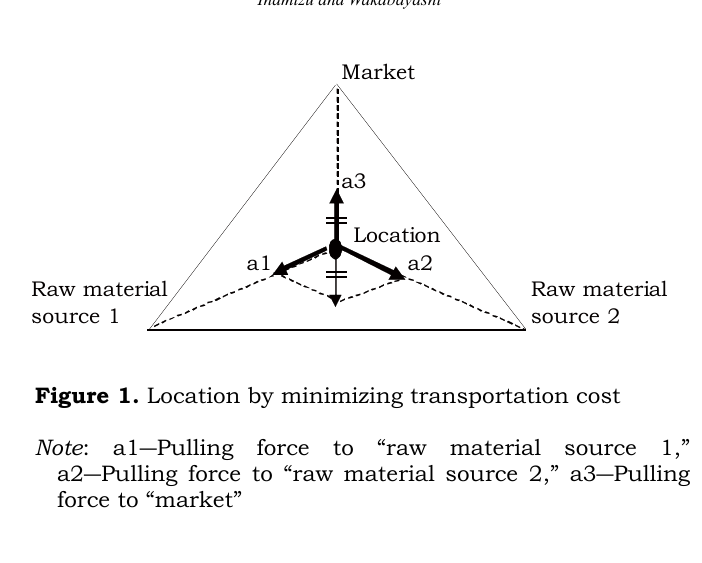
Figure 2. Naturally, if the operation moves away from the point of minimal transportation costs (the black dot in the triangle), the cost of transportation is going to increase. The circles show the set of locations where the increase in transportation costs is equal. For example, the circle marked 200 represents all the locations where the cost of transportation is going to be 200 higher than the point of minimal transportation costs. These cost curves are like concentric contour lines around the black dot in the triangle. Let us say that at point B we can save 200 or more in labor costs. If this is the case, since point B falls within the 200 cost curve, point B yields greater savings in labor than the increase in transportation costs. Therefore, it is more desirable for the operation to be based at point B rather than point A.